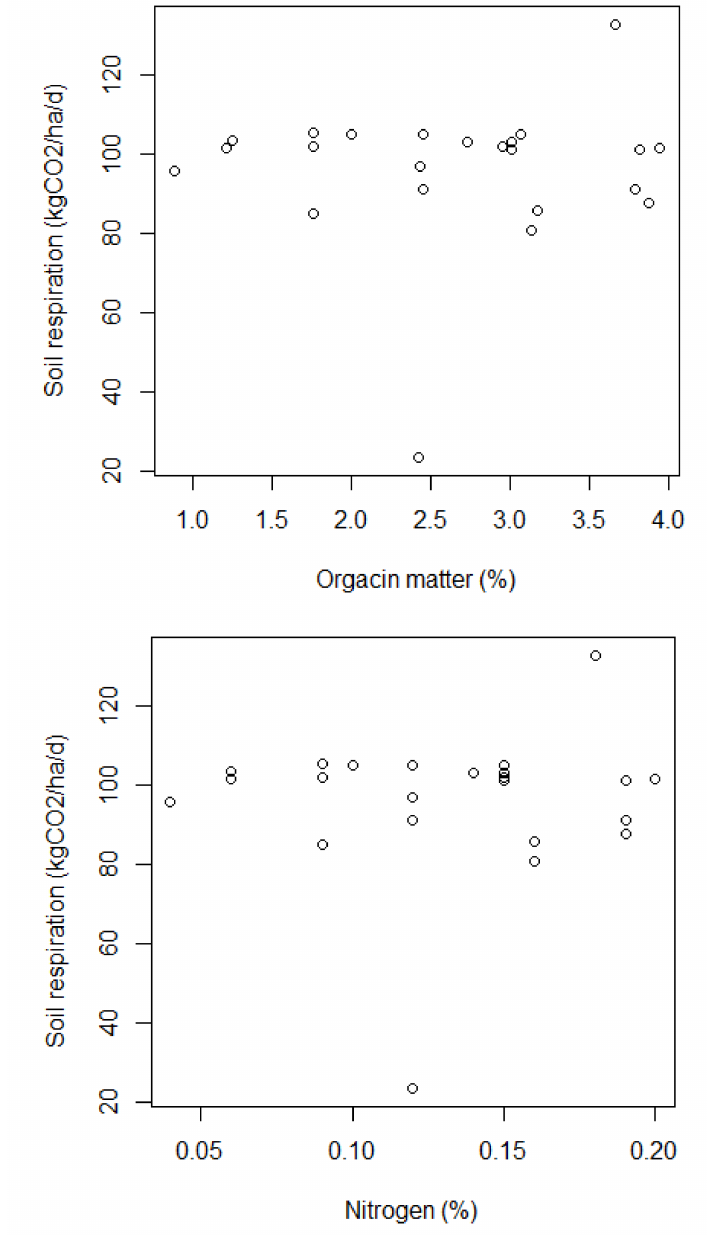
Figure 1. Soil respiration compared with organic matter and nitrogen in